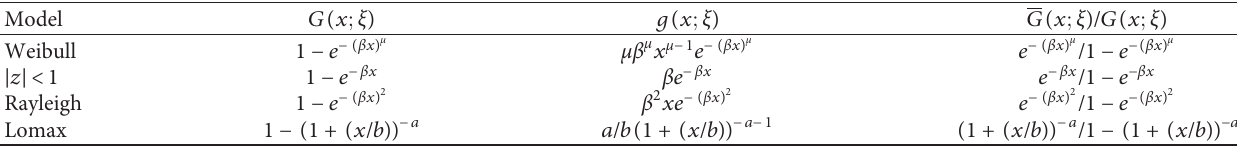
Table 1: Some new models of the new